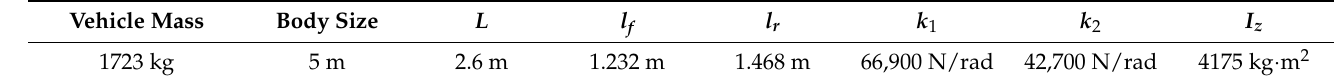
Table 3. Vehicle dynamic